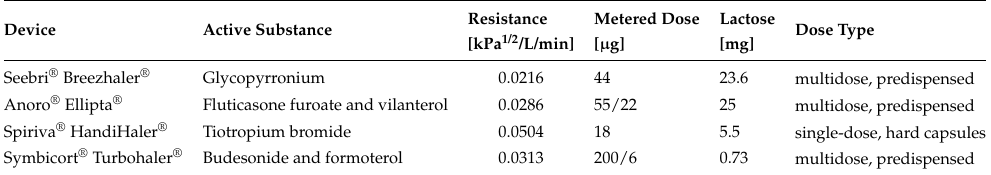
Table 2. Summary of the relevant parameter values of the used DPIs taken from the literature